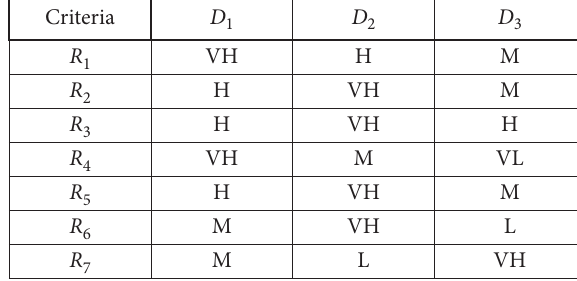
Table 4. Importance of criteria evaluated by